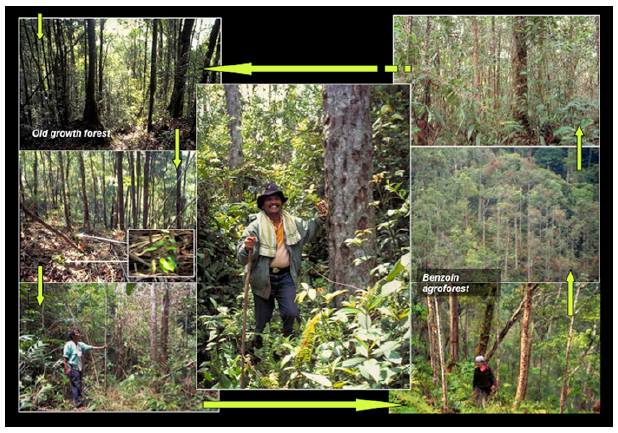
Fig. 5 . Fostered silvigenetic development processes in the establishment of Benzoin Agroforest in North Sumatra, Indonesia: farmers introduce benzoin seedlings in the